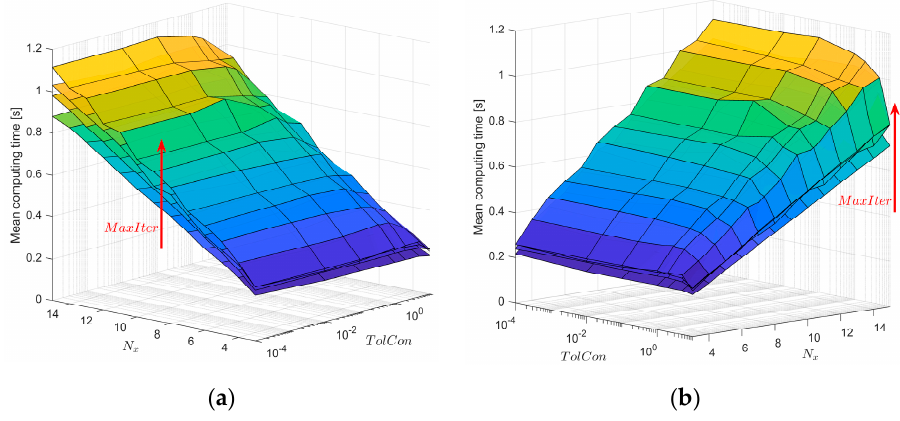
Figure 16. DoE with variable N x , MaxIter and TolCon : ( a , b ) Average computing time in function of the varied parameters.